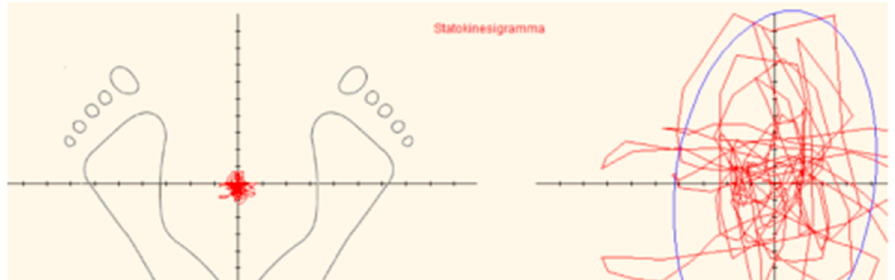
Figure 1. Statokinesigram (SKG). SKG surface (SKG-S) is expressed in square millimeters (mm 2 ) and was computed by calculating an elliptic area which corresponds to 90% of the COP positions over time. This procedure is designed to eliminate 10% of the more extreme positions of COP, which could be due to involuntary perturbations of quiet stance.